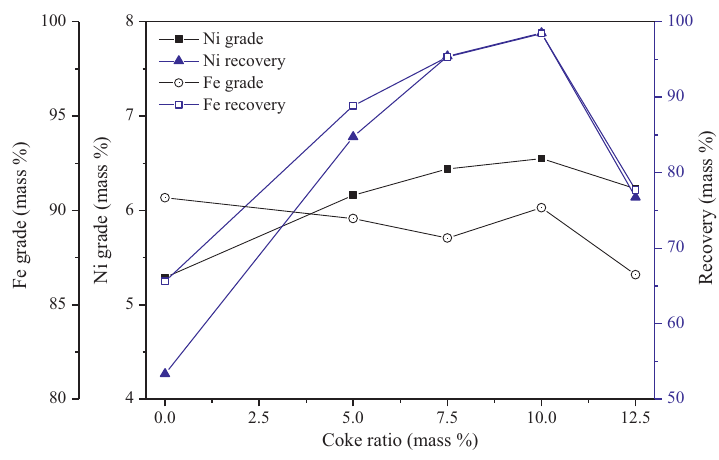
Figure 4: Effects of coke ratio on Fe and Ni grade and recovery of ferronickel (Smelting at 1,550°C for 10 min, with binary basicity of slag as 1.0, 18% of MgO and 3% of Al 2 O 3 in slag).